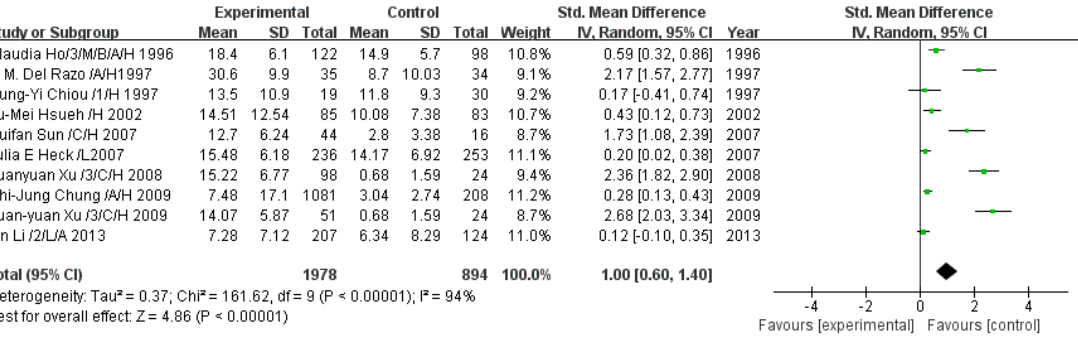
Figure 6. Effect of arsenic exposure on inorganic arsenic percentage (iAs%) in urine. Std., standardized; SD, standard deviation; IV, independent variable; CI, confidence interval